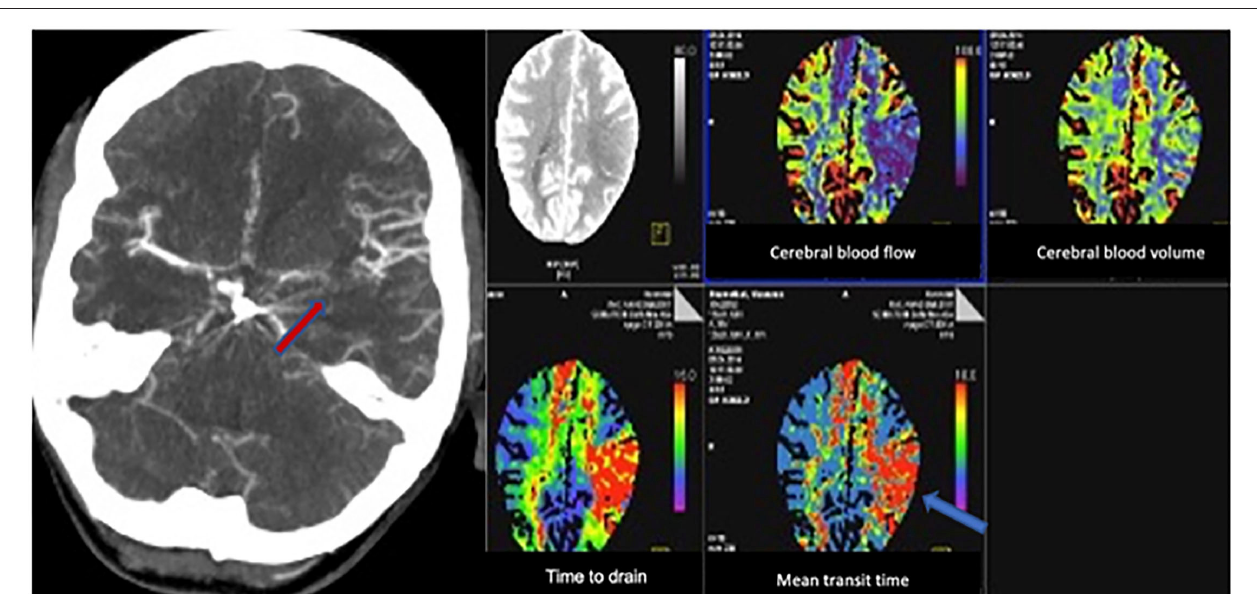
FIGURE 1 | Example of a patient with an indication for ERT with severe vasospasm on the CTA (red arrow, left) with perfusion deficits in the middle cerebral artery territory on the CTP (blue arrow, right).